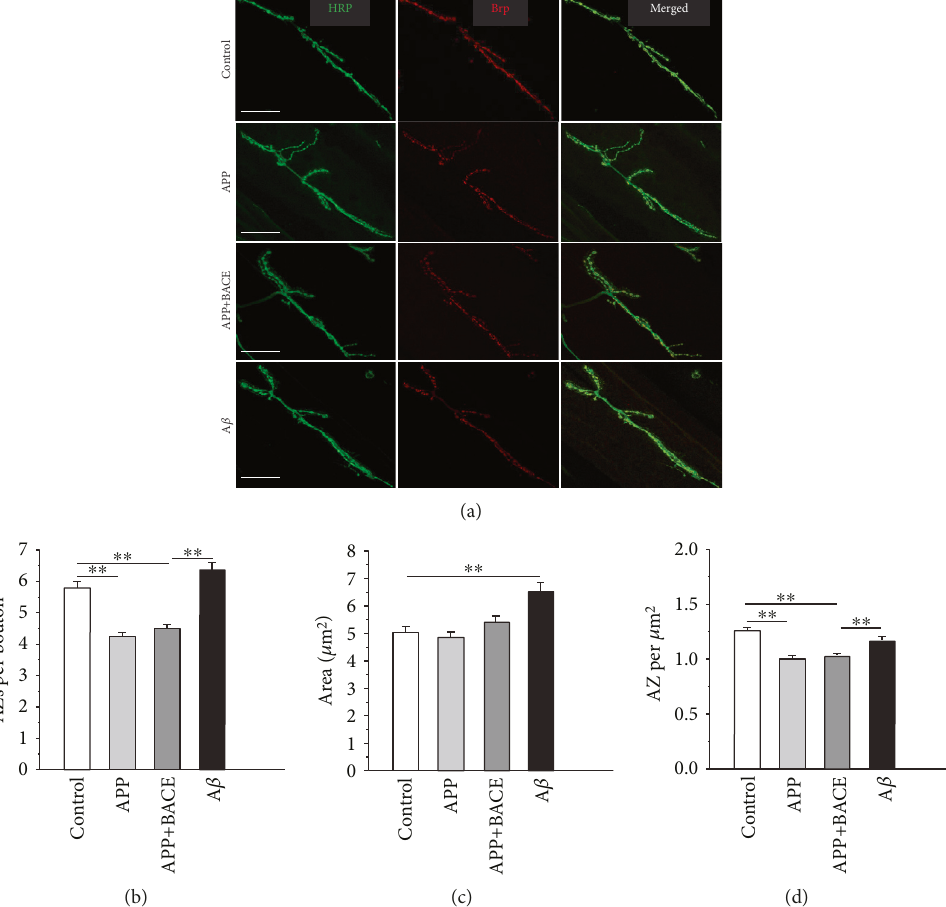
Figure 4: Muscle 6 and 7 neuromuscular junctions. (a) Bruchpilot and corresponding active zones distribution in synaptic boutons from transgenic Drosophila melanogaster larvae. Representative confocal images from the control, APP, APP+BACE, and А β lines are shown. Muscle 6 and 7 neuromuscular junctions were costained with antibodies against HRP (green channel) and the presynaptic AZ protein Brp (red channel). Scale bars, 25 μ m. (b) Average number of active zones per bouton. (c) Average boutons area, μ m 2 . (d) Spatial density of AZs per μ m 2 . Data are presented as mean ± SEM. ∗∗ P < 0 01 compared to corresponding bar.